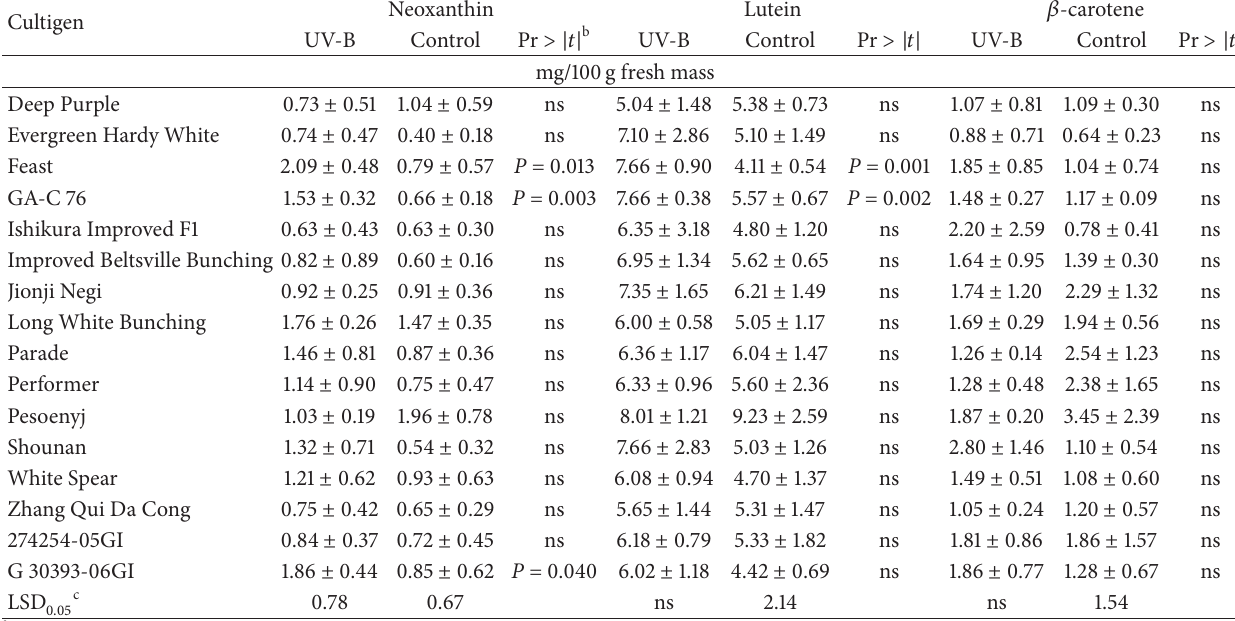
a Composition of 𝑛 = 6 plant samples from 4 replications ± standard deviation. b Significance based on paired Student’s t -test among treatments; ns: not significant. c LSD for differences between cultivar means 𝛼 = 0.05